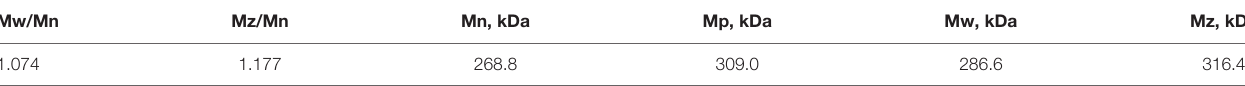
TABLE 1 | Molecular weights.